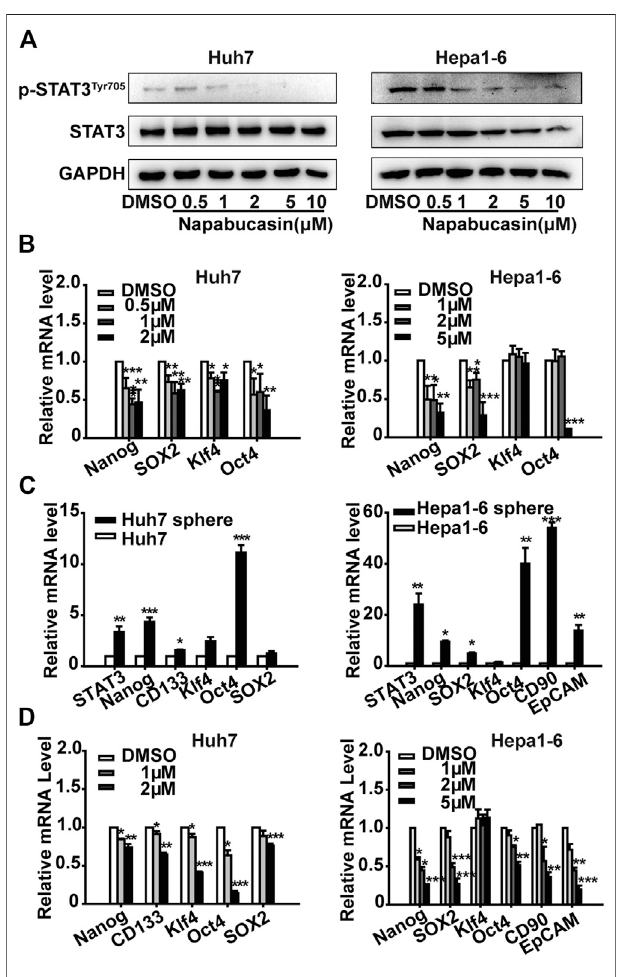
FIGURE 4| Napabucasin down-regulates p-STAT3 Tyr705 and stemness markers. (A) Immunoblot showing STAT3 and p-STAT3 Tyr705 levels in Huh7 and Hepa onetosixcells treatedwith differentconcentrationsofnapabucasin for 12 h. (B) STAT3 and stemness markermRNAsin thesuitablytreated Huh7 and Hepa1-6 cells. Data were normalized to β -actin. (C) STAT3 and stemness marker expression in spheroid derived from Huh7 and Hepa1-6 cells. (D) Stemness marker expression in Huh7 or Hepa1-6 cell-derived spheres treated with indicated concentrations of napabucasin for 12 h. Data are shown as mean ± SD of three independent experiments (* P < 0.05, ** P < 0.01 and *** P < 0.001).